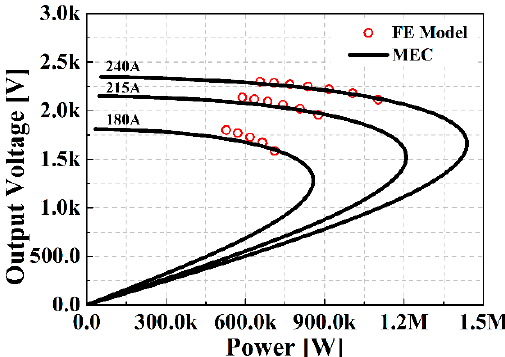
Figure 14. Comparison of the power–voltage curve (FE model vs. MEC).